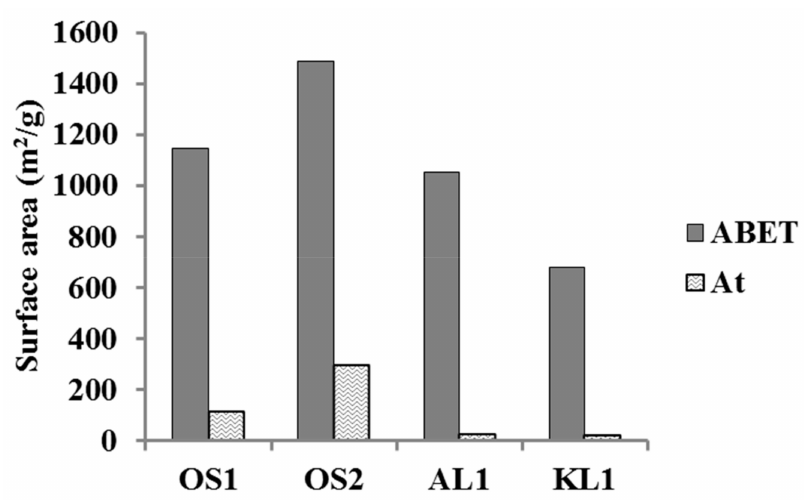
Figure 2. Comparison of the apparent surface area (A BET ) and external surface area (A t ) derived from N 2 adsorption-desorption data of the di ff erent ACMs.